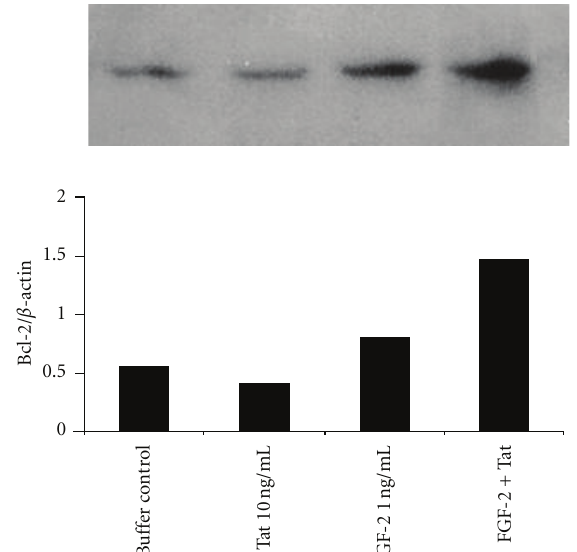
Figure 2: Induction of Bcl-2 protein expression by FGF-2 and/or Tat in human primary endothelial cells. HUVECs were cultured in the presence of Tat (10ng/mL) and/or FGF-2 (1ng/mL). HUVECs treated with the protein suspension bu ff er (PBS-0.1% BSA) were used as controls. After 24hours of culture, HUVECs were lysed, and equal amounts of total proteins were electrophoresed and analysed by Western blotting using monoclonal antibodies directed against human Bcl-2. Blots were reprobed with anti- β actin monoclonal antibodies to verify equal loading of protein in each lane. In the upper panel a representative Western blot for Bcl-2 protein is shown. In the lower panel is its densitometric analysis, which is presented as the Bcl-2 to β actin ratio. Repeated experiments (two) gave similar